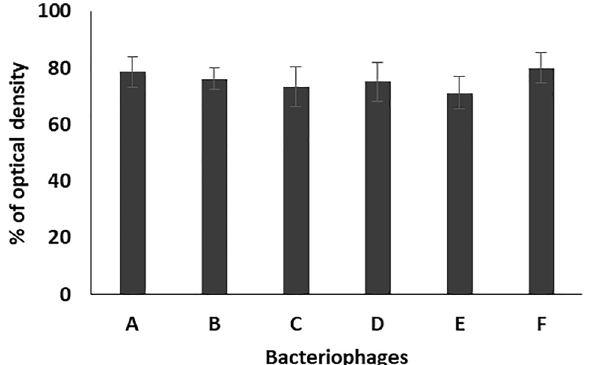
Figure 6. Percentage of the formed biofilms of 17 enterococcal isolates, prepared in different dilutions (1/10, 1/100, 1/500, and 1/1000) from bacterial suspension adjusted to 0.5 MacFarland, after treatment the